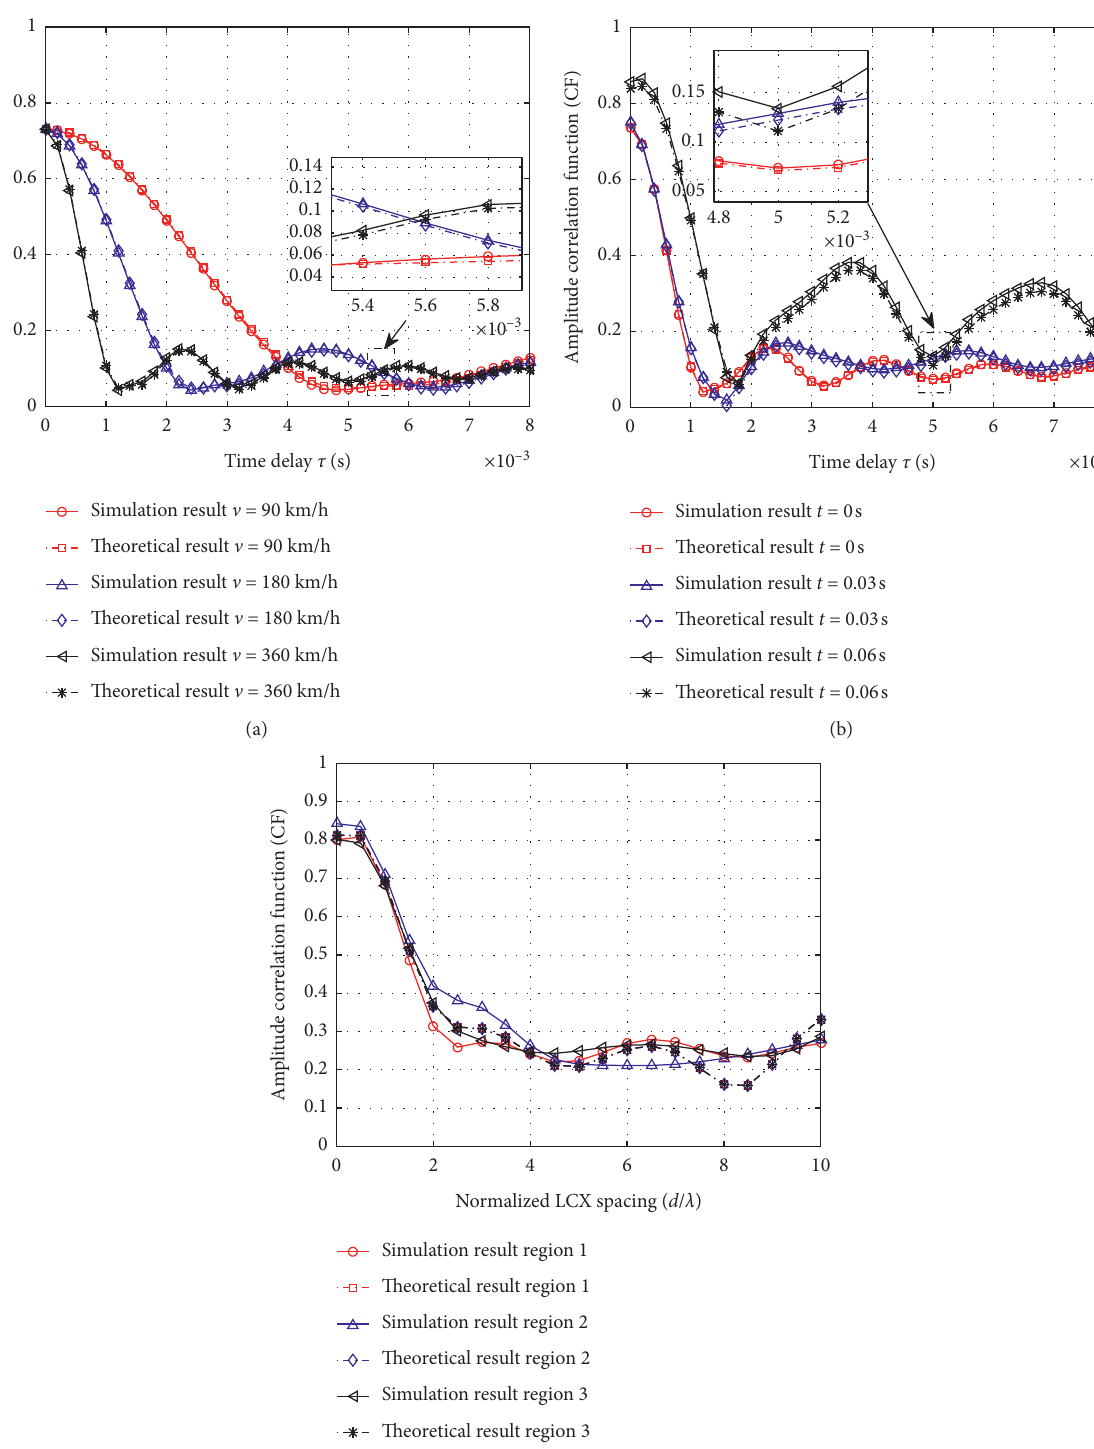
Figure 3: Amplitude correlation function (CF: LoS+ NLoS): (a) different moving speed and time delay ( t � 0 s, d � 0.7 λ ); (b) different time and time delay ( v � 360km/h, d � 0.7 λ ); (c) different region Rx1 in tunnel and LCX spacing ( τ � 0.5ms, t � 0.06s, v �